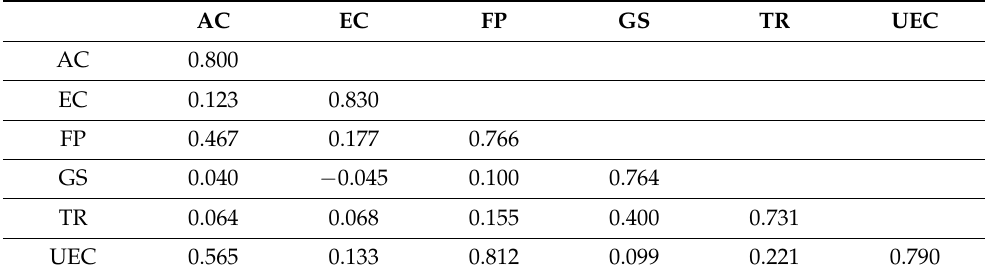
Table 4. Discriminate validity matrix.